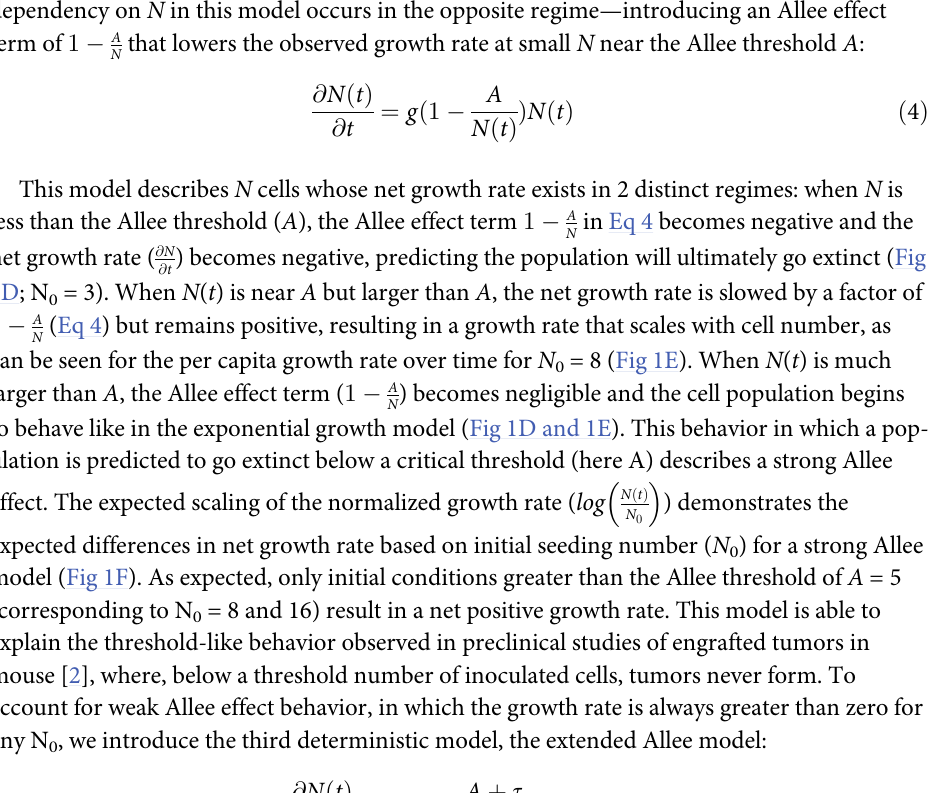
(Fig 1B) for initial cell numbers N ( t = 0) = 3, 8, and 16 cells displayed in (Fig 1A, 1B and 1C). In the remainder of the manuscript we denote the initial cell number, N ( t = 0) by N � � malized growth rate ( log N ð t Þ ) is constant for each initial condition, with all growth N 0